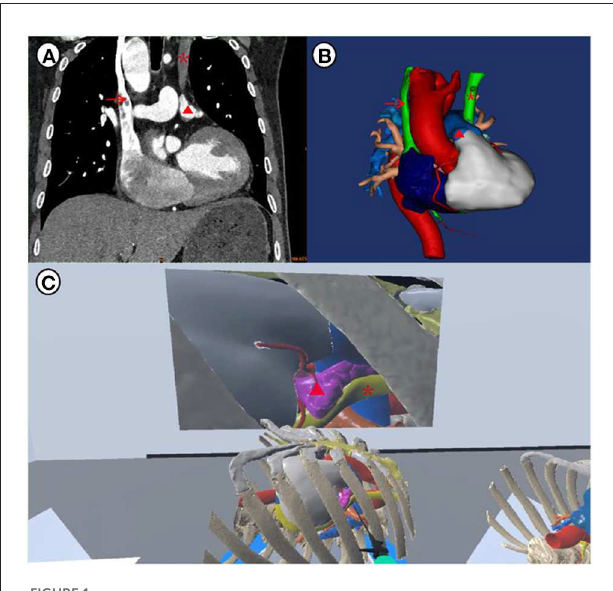
FIGURE1 Preprocedural planning and simulation: (A) anatomical identification of PLSVC by CT; (B) three-dimensional reconstruction of the cardiac structures; (C) detection of the PLSVC and simulation of the thoracoscopic ablation using virtual reality tools. Surgeons’ views can be obtained on this platform, and the 3D model can be zoomed in or out in a 360-degree version. The red triangle indicates left atrial appendage, the red arrow indicates right superior vena cava and the red asterisk indicates